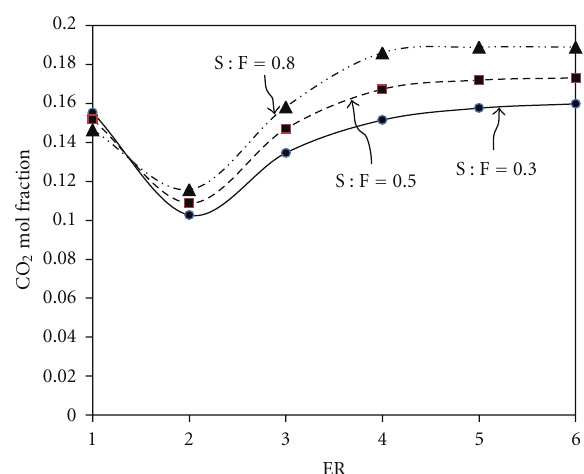
Figure 4: E ff ect of ER on CO 2 production for various S:F, estimated with chemical